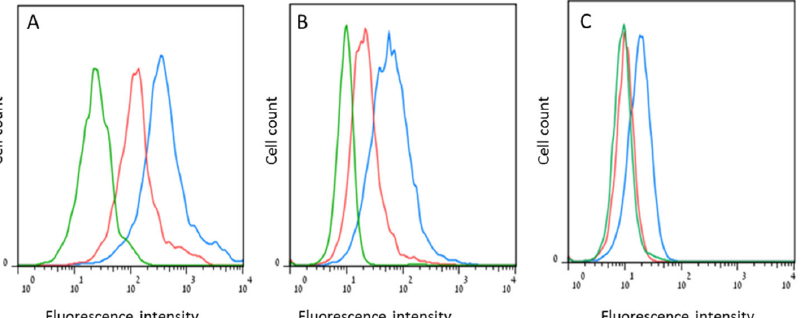
Figure 6. Cell surface vs. whole cell expression of p14 using flow cytometry and Mab M-66 as first antibodies. ( A ) T-25 cells that contain MMTV; ( B ) MCF-7 cells ectopically expressing p14: ( C ) MCF-7 cells devoid of p14. Green—Control, no. 1st antibody; Red—Intact cells (cell surface expression; Blue—Permeabilized cells (whole cell expression). Adapted from Ref. [81].